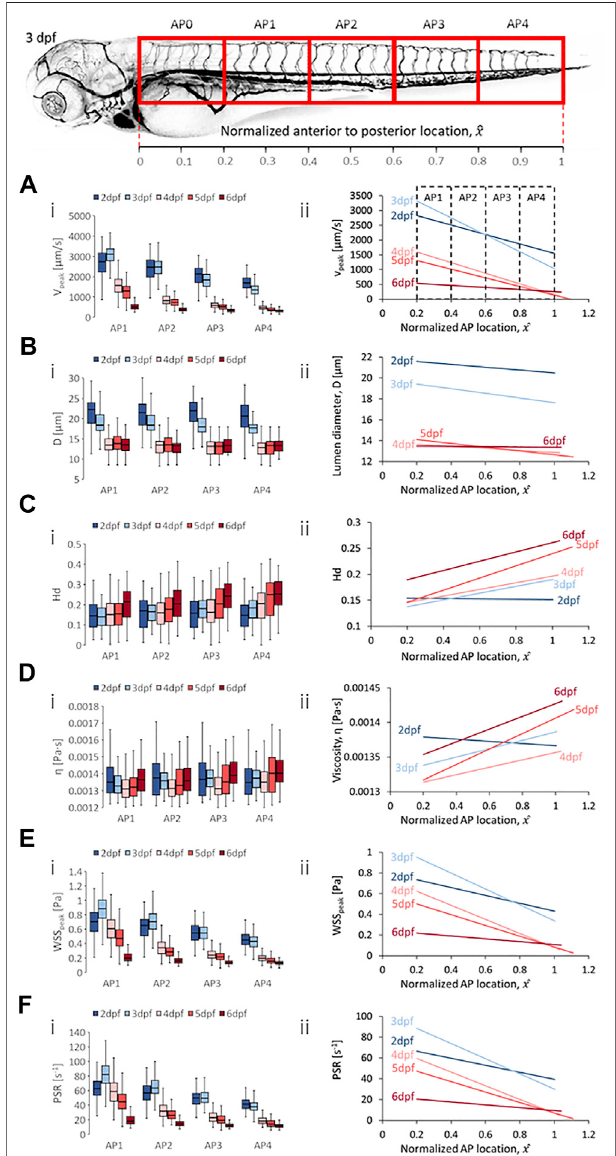
FIGURE 4 | Developmental trends of morphological and hemodynamic quantities in the dorsal aorta/caudal artery (DA/CA). (A) The changes in V peak at four regions along the anterior-to-posterior (AP) axis (i) and the AP trend for V peak (ii) . (B) The changes in D at four AP regions (i) and the AP trend for D (ii) . (C) The changes in H d at four AP regions (i) and the AP trend for H d (ii) . (D) The changes in η at four AP regions (i) and the AP trend for η (ii) . (E) The changesin WSS peak atfourAPregions (i) andtheAPtrendfor WSS peak (ii) . (F) The changes in PSR at four AP regions (i) and the AP trend for PSR (ii) . Box plots in (i) of Panels (A – D) show the median and the fi rst (Q1) and third (Q3) quartile levels of the hemodynamic quantity for the pooled zebra fi sh data. The whisker bars represent the maximum and minimum ranges of the data that lie within 1.5timesofthe interquartile range (IQR =Q3 − Q1) beyond Q1and Q3.